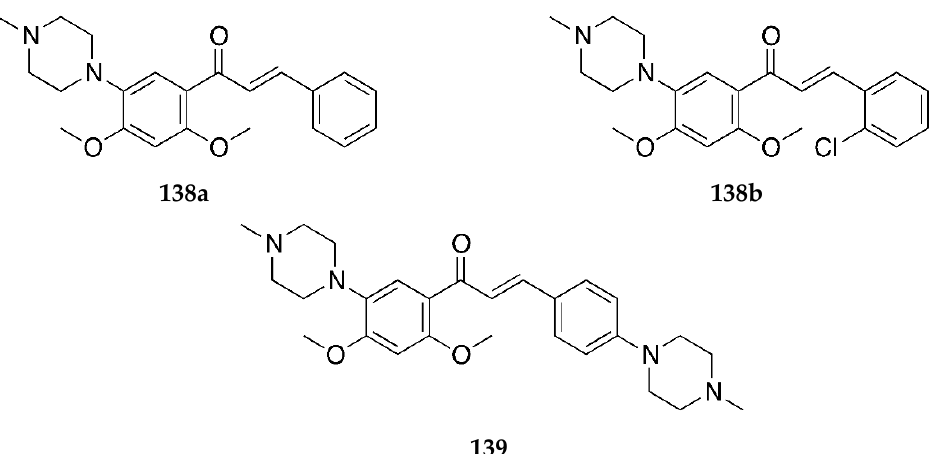
Figure 52. Chemical structures of N,N -dialkyl-3-aminochalcone derivatives.